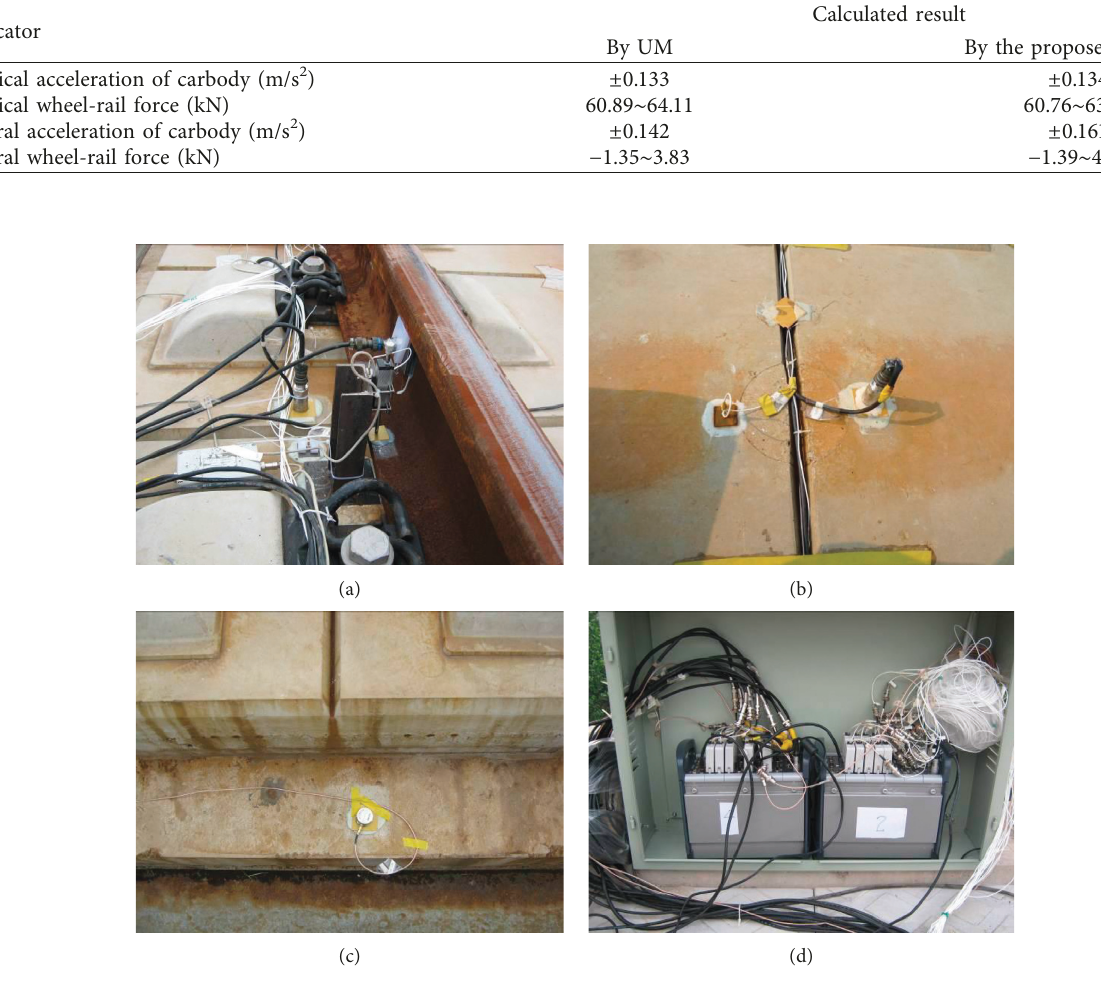
Figure 5: Field test on a high-speed railway with the slab ballastless track: (a) measurement of the displacement and acceleration of the rail, (b) measurement of the acceleration of the slab, (c) measurement of the acceleration of the base, and (d) the data acquisition